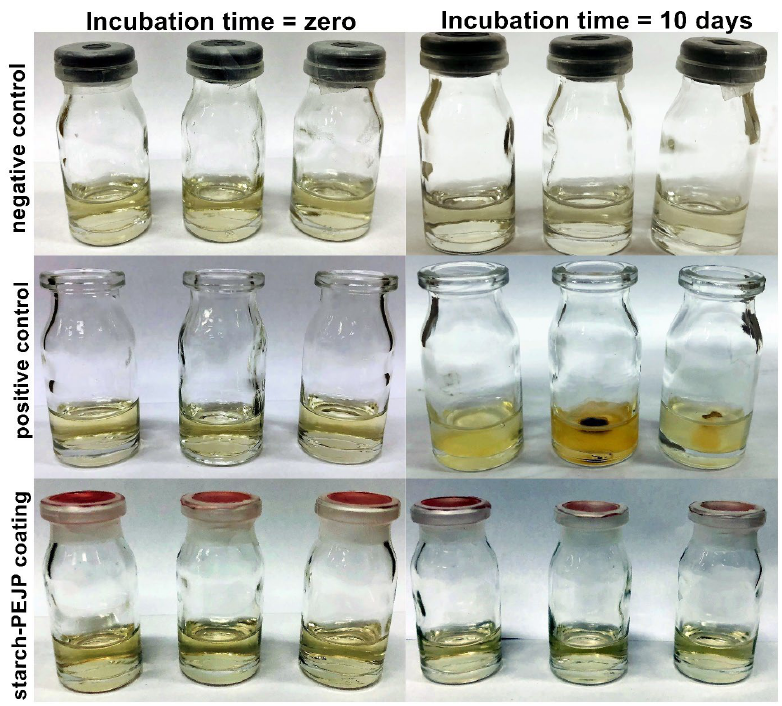
Figure 9. Photographs of antimicrobial permeation test before and after ten days of incubation at room temperature (25.0 ± 2.0 °C).